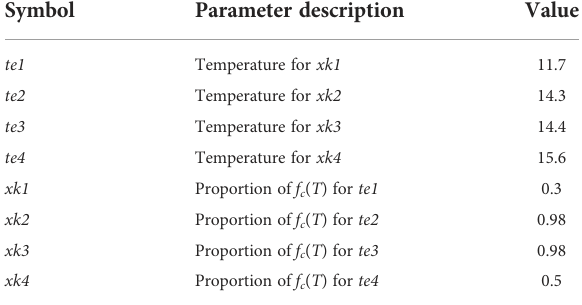
TABLE 1 Parameter values of f c ( T )